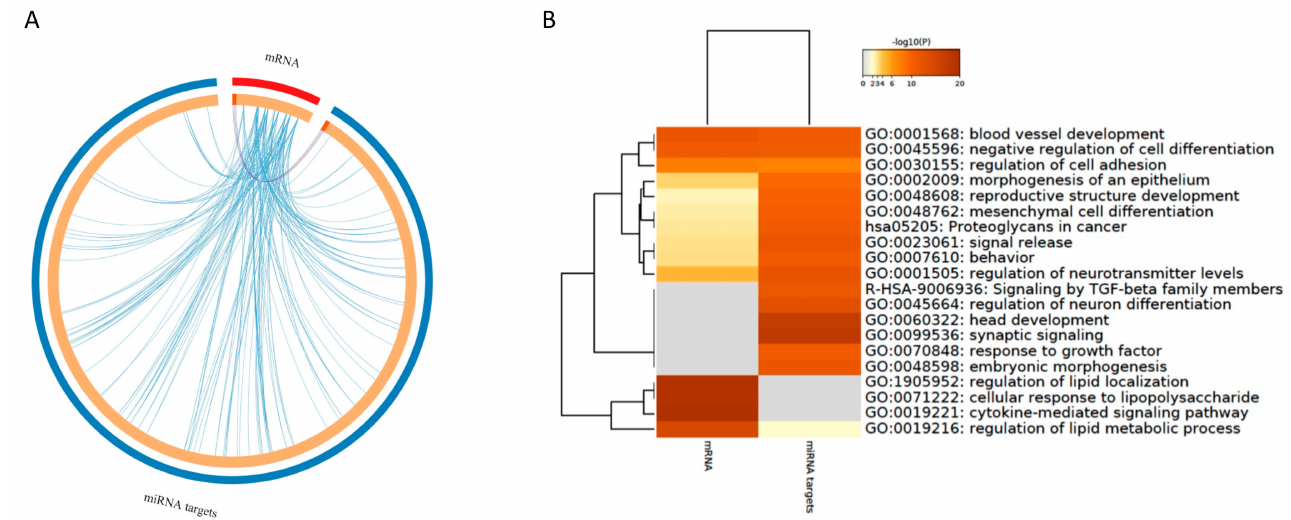
Figure 8. Comparative analysis of mRNAs extracted from the literature and the predicted miRNA targets. ( A ) Overlapping genes (purple curves) and genes that share the same enriched term (blue curves). ( B ) Heatmap of enriched terms, colored by p